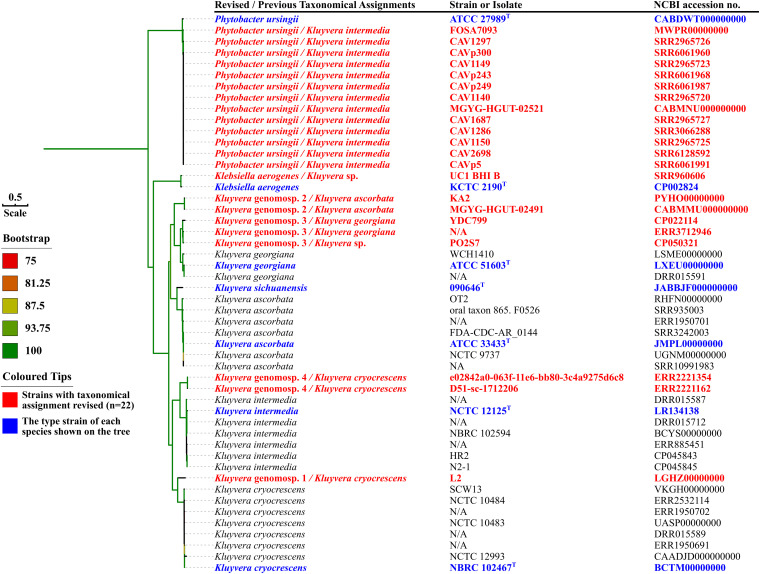
Maximum-likelihood phylogenomic tree of Kluyvera sichuanensis 090646T and the 47 genomes labeled as Kluyvera based on the core genome. Strains and their nucleotide accession numbers are listed alongside the names of species. Type strains are depicted in blue. For genomes that are labeled as Kluyvera in GenBank but need to be revised as suggested in this study (depicted in red), the revised species names are shown first, while the current labels are shown after the slash. Genomosp. 1–4 are tentative Kluyvera species (Supplementary Table 3). The tree was inferred using the maximum likelihood method under GTRGAMMA model with a 1,000-bootstrap test and branches with support over 75% are indicated by different colors. Bar, value indicates the nucleotide substitution per site.